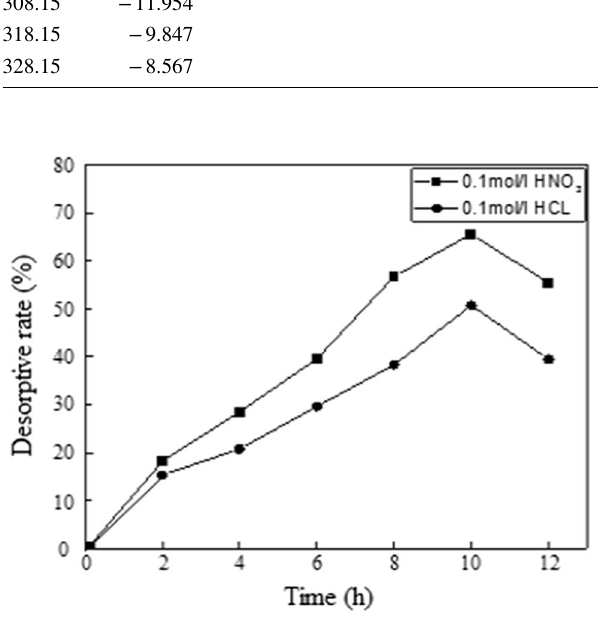
Fig. 15 Relationship between desorption rate and